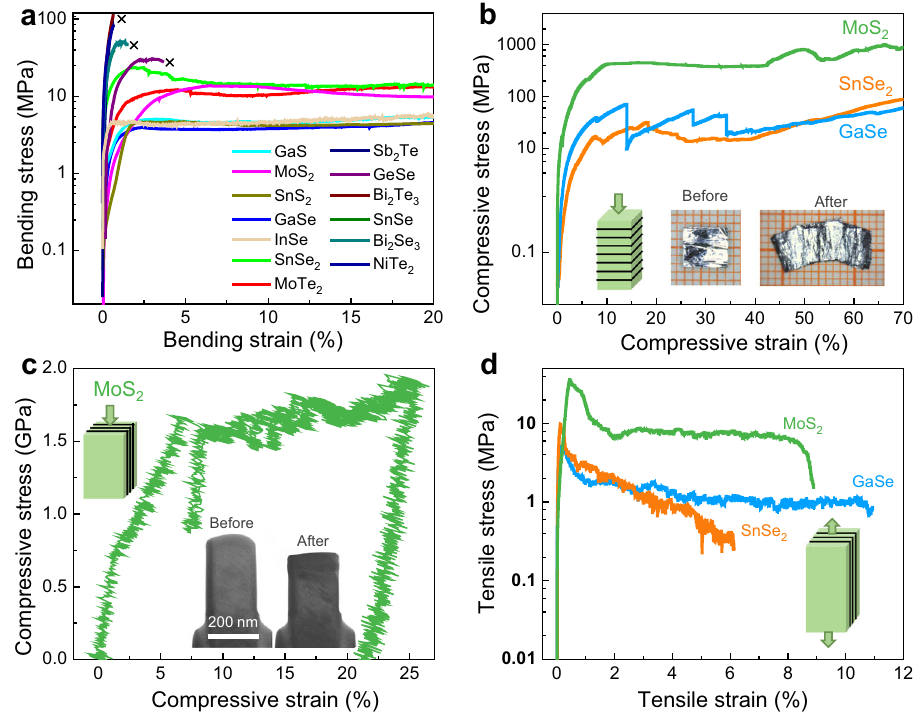
Fig. 3 | Mechanical properties of selected 2D vdW crystals. a Three-point bending stress-strain curves for the selected crystals. b Compressive stress-strain curves for MoS 2 , GaSe, and SnSe 2 crystals. The inset photos show a MoS 2 crystal before and after compression. c In situ compressive stress-strain curve of a MoS 2